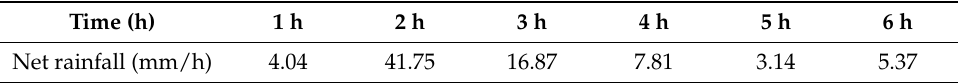
Figure 16. Flood simulation on the DEM constructed by using QHSP method at t = 2.